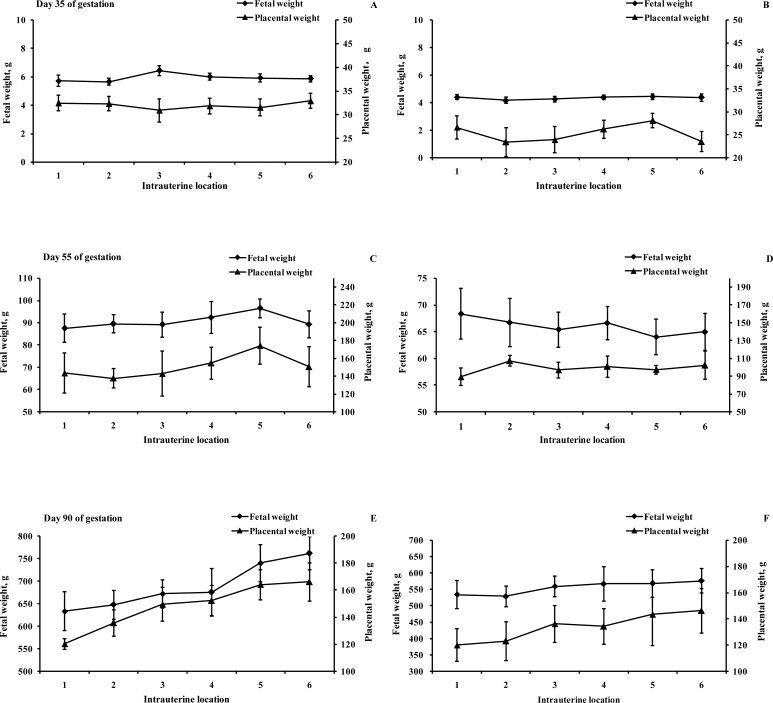
Distribution of fetal and placental weights (g) within the uterine horn on day 35, 55 and 90 of gestation.Fetal and placental weights of Large White gilts in relation to fetal rank within the uterine horn (A, C, E); Fetal and placental weights of Meishan gilts in relation to fetal rank within the uterine horn (B, D, F). Fetal positions within the uterine horn were numbered from cervix (1) to tubal (6).